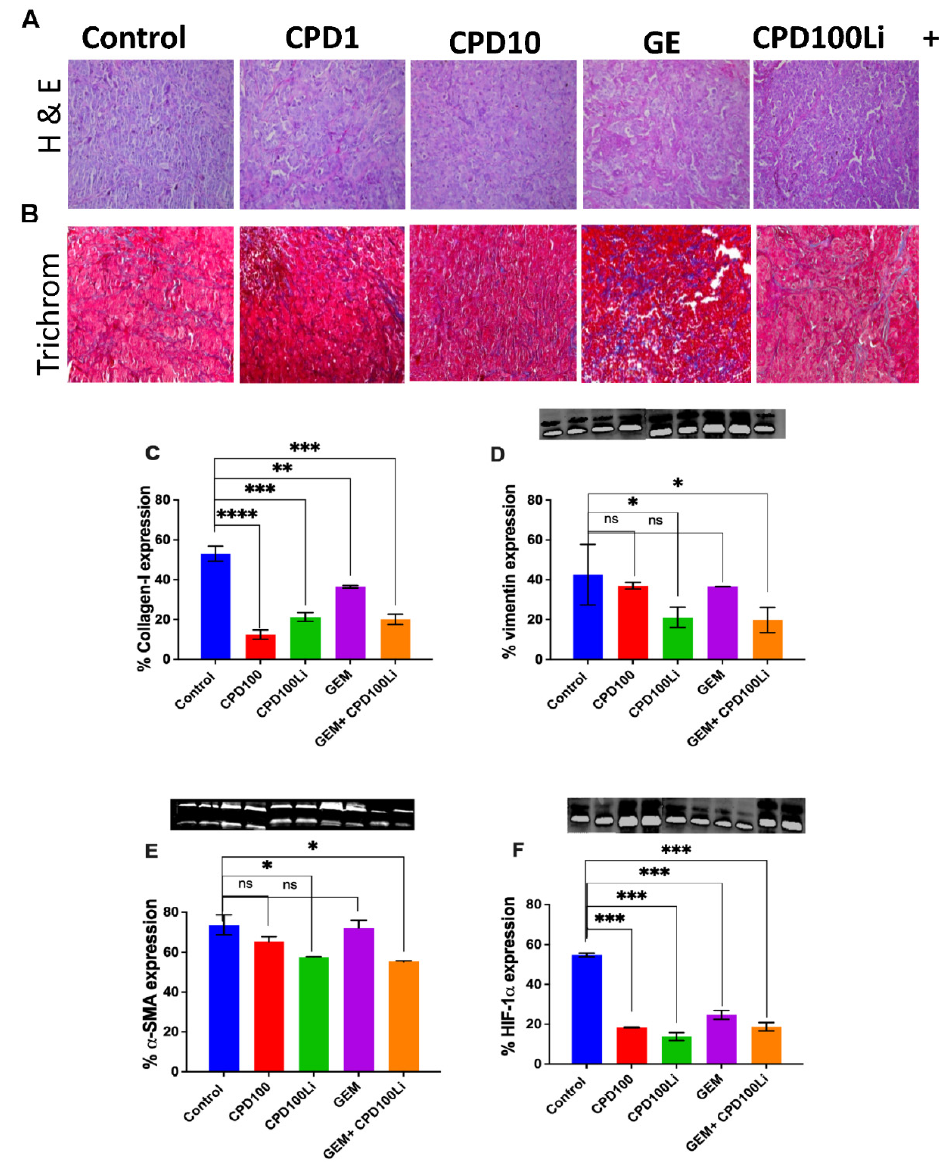
Figure 5. H&E-trichrome stains and immunoblots. Representative H&E and Masson’s trichrome stain of tumors from the treatment groups: control, CPD100, CPD100Li, GEM, CPD100Li + GEM, scale bar represents 200 μ m ( A ), % collagen quantified in trichrome stain using ImageJ and immunoblots of ( B ), % α -SMA expression ( C ), % vimentin expression ( D ), and % HIF1A expression ( E ). Error bars are standard deviations. ns ( p > 0.05), * ( p ≤ 0.05), ** ( p ≤ 0.01), *** ( p ≤ 0.001), and **** ( p ≤ 0.0001) represent the statistical significance compared to control group by one-way ANOVA.